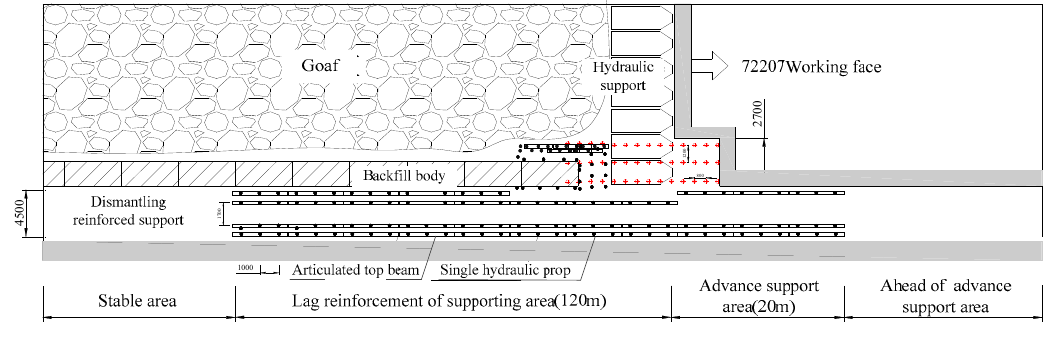
Figure 10. Schematic of strengthening support in gob-side entry retaining.